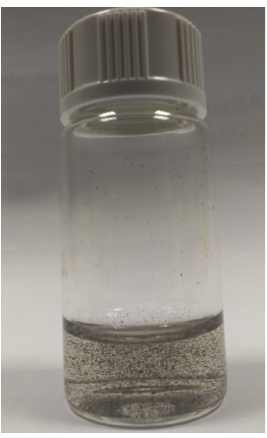
Figure 2: Appearance of the dispersion composed of carbon nan- otubes (CNTs) mixed with saline solution in which concentration is